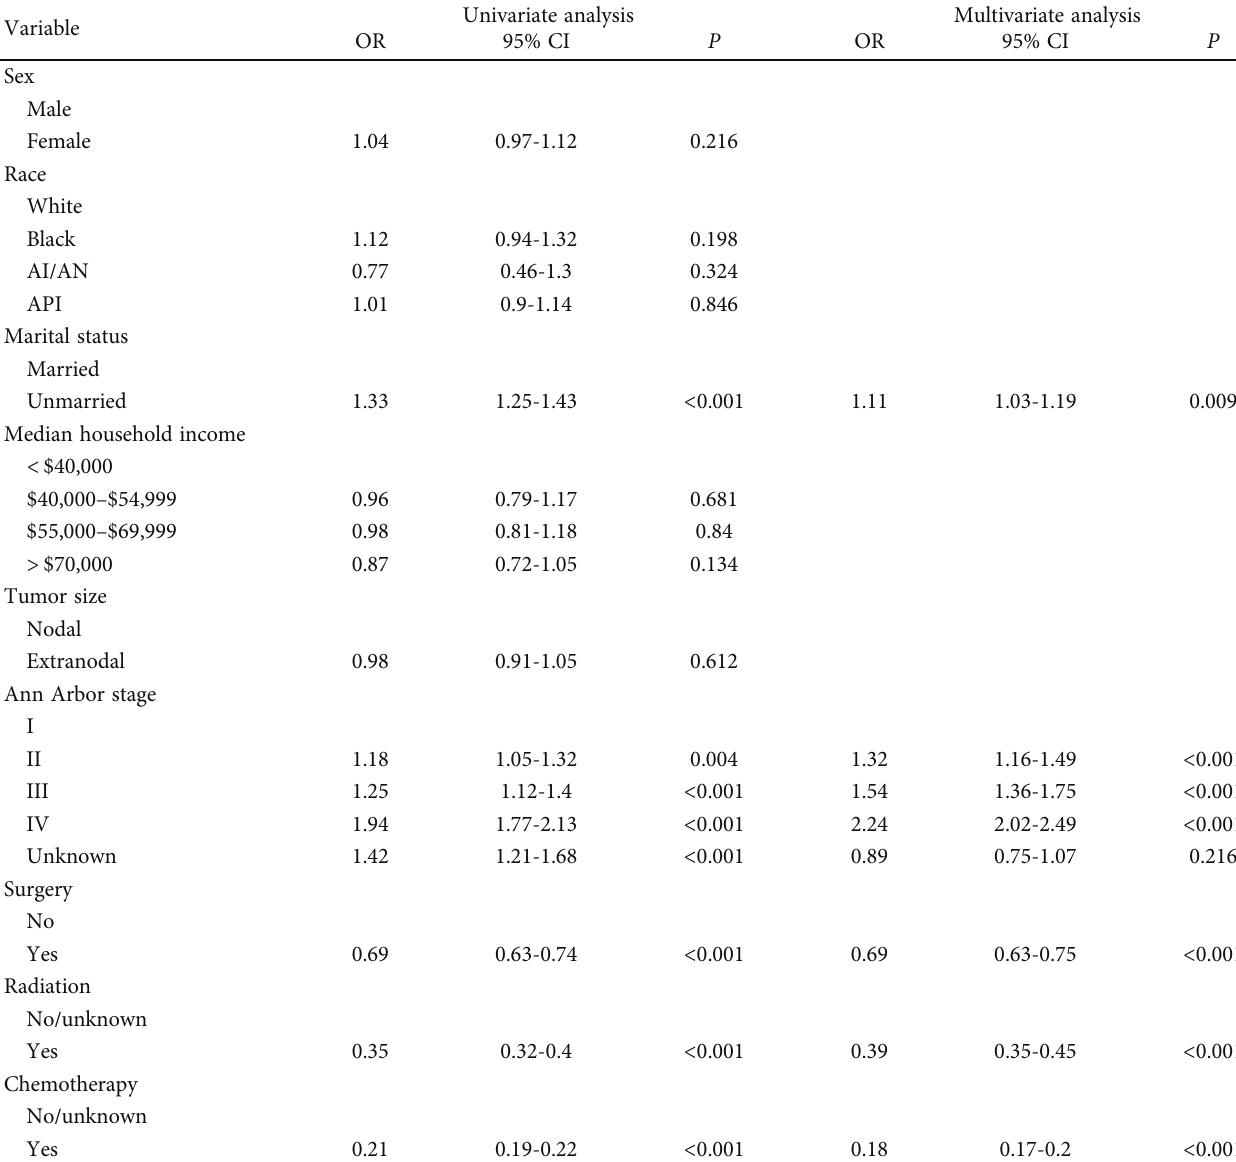
Table 4: Univariate and multivariate logistic analyses of variables associated with risk of CSS for older DLBCL